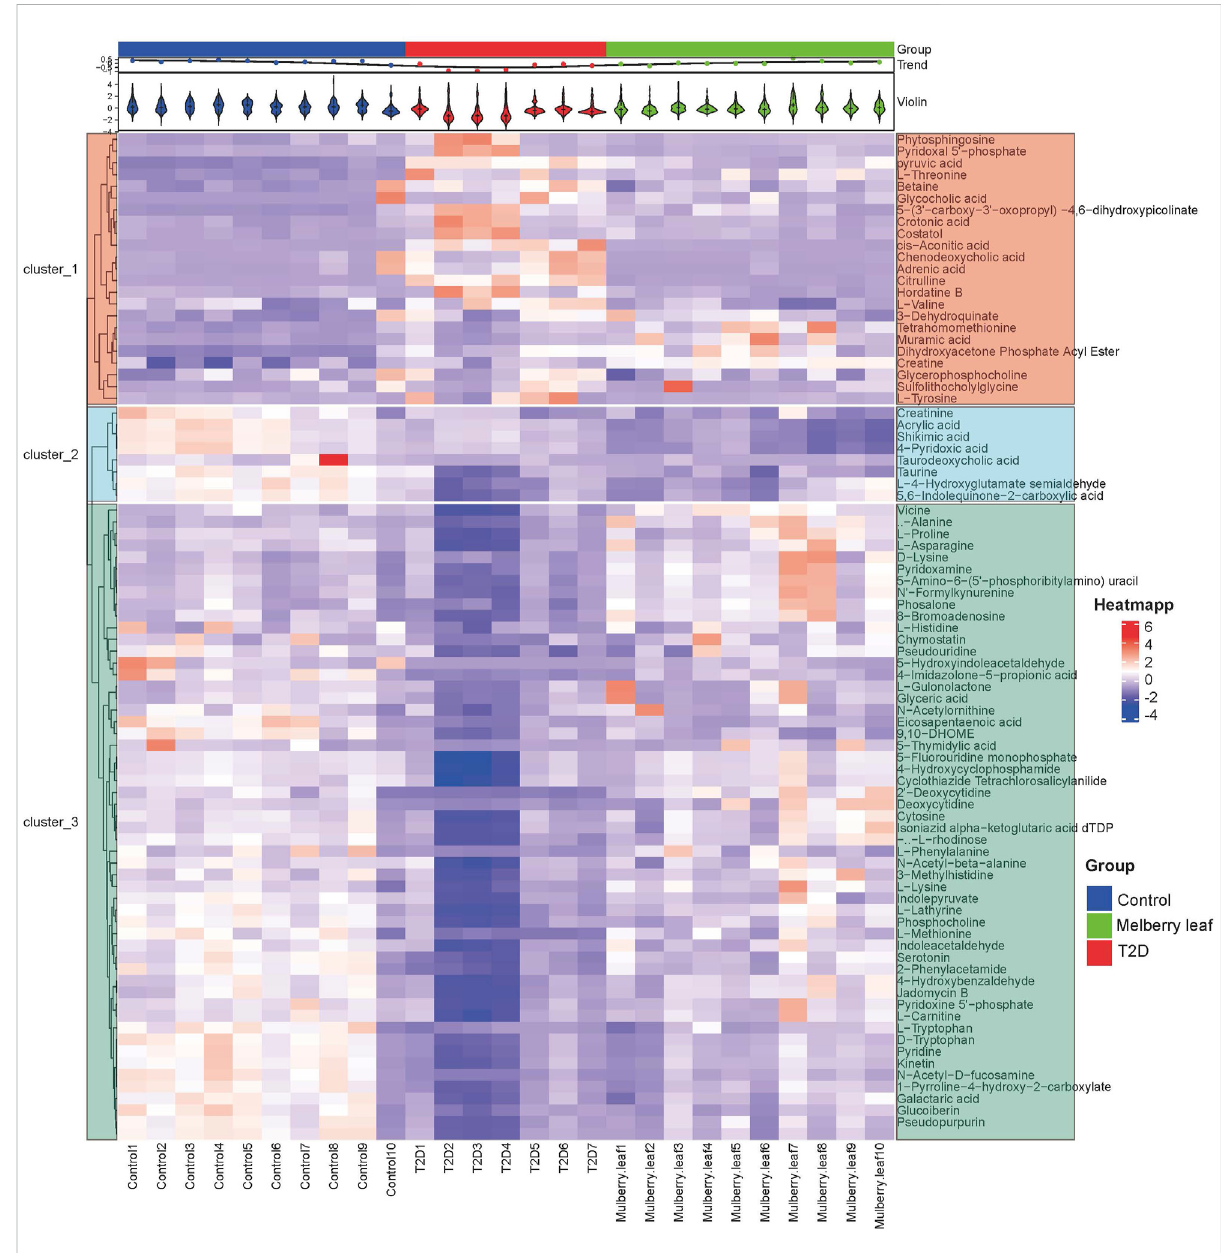
FIGURE 6 Heatmapofthedifferentialmetabolitesintheserumofrats(Redandbluerepresentincreasedanddecreasedmetabolitecontent,respectively).